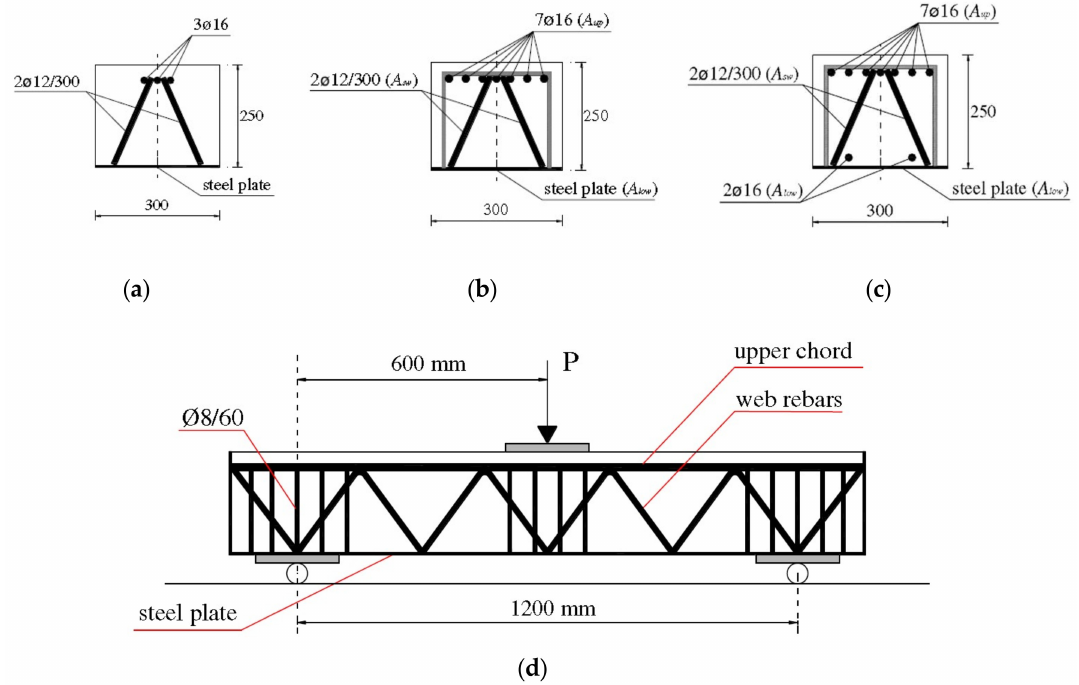
Figure 18. Dimensions of cross-section of tested specimens (mm); cross-section of: ( a ) truss; ( b ) specimens A1, B1, and B2; ( c ) specimens A2-1; ( d ) longitudinal section of a tested specimen and load configuration (series B) (Colajanni et al.,